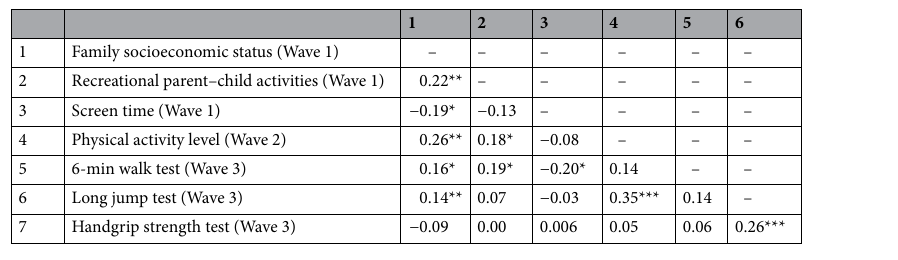
Table 2. Correlation matrix for study variables. *p < 0.05; **p < 0.01; ***p <